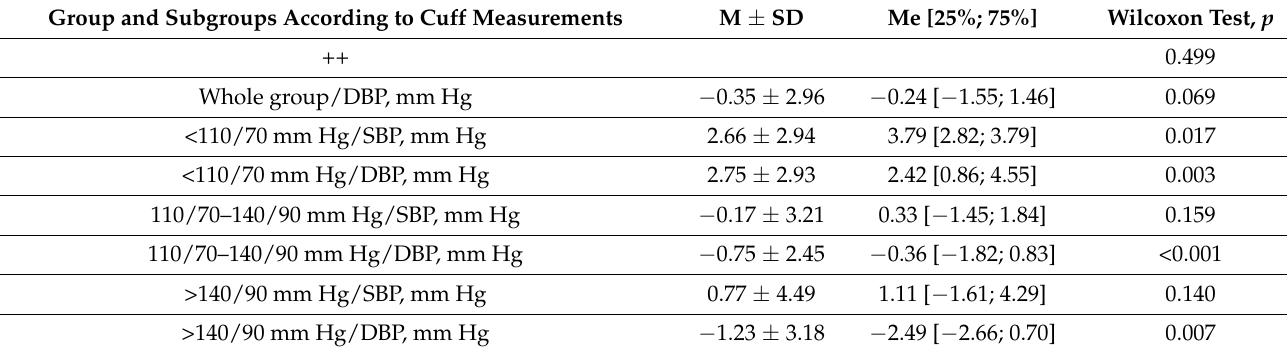
Figure 6. Boxplots of deviations between the two methods in the whole group ( n = 500) and in three subgroups (BP < 110/70, n = 14; 110/70–140/90, n = 420; >140/90, n = 66) according to the cuff-based results. Mean and median error differed in different subgroups. Wilcoxon rank test was used to access the significance of errors. The cuffless method overestimated BP compared to the cuff-base method significantly in patients with BP values < 110/70 mm Hg both in the SBP and in the DBP subgroup, and underestimated DBP in the subgroups with patients with BP values 110/70–140/90 mm Hg and >140/90 mm Hg. SBP = systolic blood pressure, DBP = diastolic blood pressure (Table 1). Table 1. Mean and median cuffless–cuff errors, mm Hg. Group and Subgroups According to Cuff